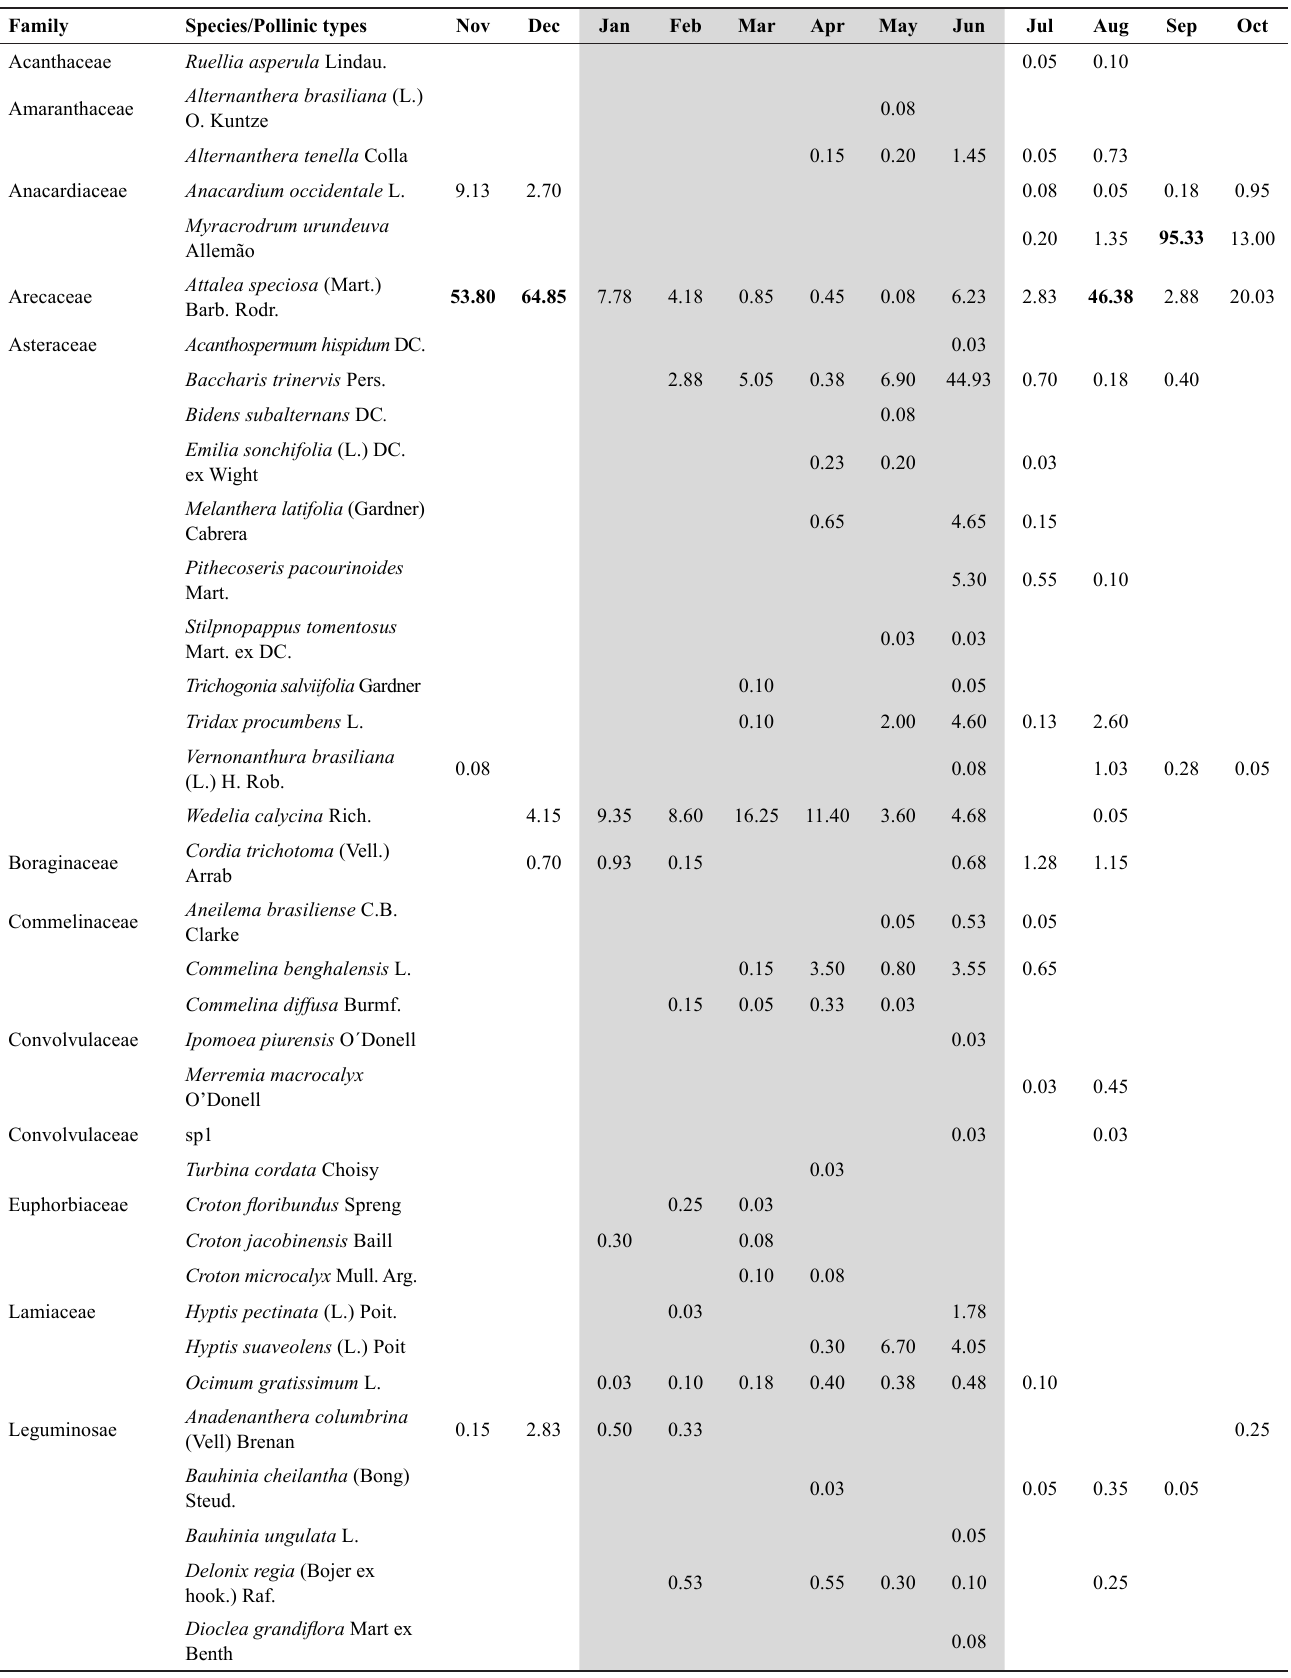
Table 1 . Temporal variation in the diet of Apis mellifera in a seasonal semideciduous forest in the State of Ceará, in the period from November 2012 to October 2013. Months highlighted in gray correspond to the rainy season and months highlighted in white represent the dry season. The values in each month correspond to the percentage of each plant species of the whole pollen collected during each